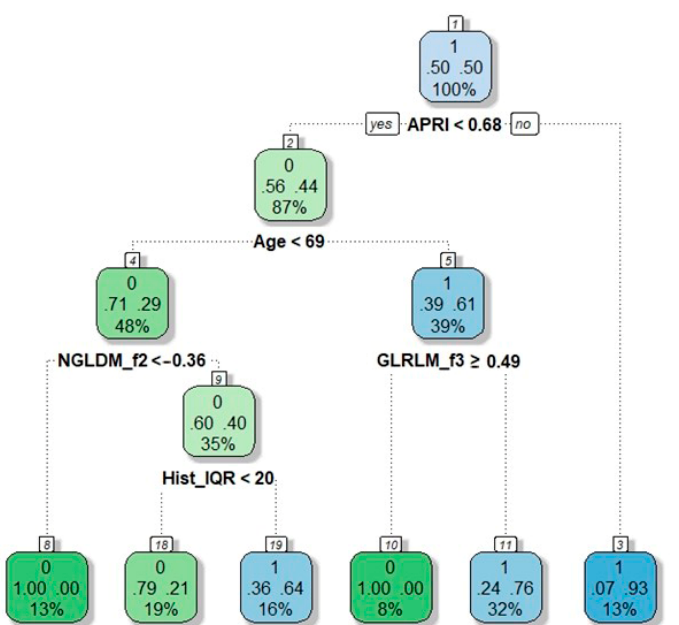
Figure 2. Decision tree for the prediction of grade 0 − 1 vs grade 2 − 3 sinusoidal dilatation (based on model in Table 3). Nodes correspond to the decision steps. Each colored square reports: (a) the response mode class in the node, i.e., the predicted outcome of that node (presence of grade 2 − 3 sinusoidal dilatation = 1; absence of grade 2 − 3 sinusoidal dilatation = 0, the top number in the square); (b) the percentages of observations in the node belonging to the first response class (absence of grade 2 − 3 sinusoidal dilatation) and the second response class (presence of grade 2 − 3 sinusoidal dilatation) (the two central numbers in the square, summing up to 1); (c) the percentage of the total population falling into the node (the bottom number in the square). Decision rules are specified on each node.